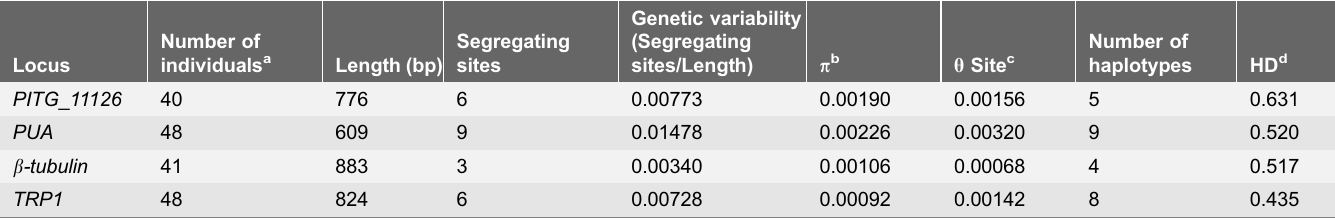
Table 2. Summary statistics of loci PITG_11126 , PUA , b -tubulin and TRP1 from Phytophthora infestans in North America. Number of Locus individuals